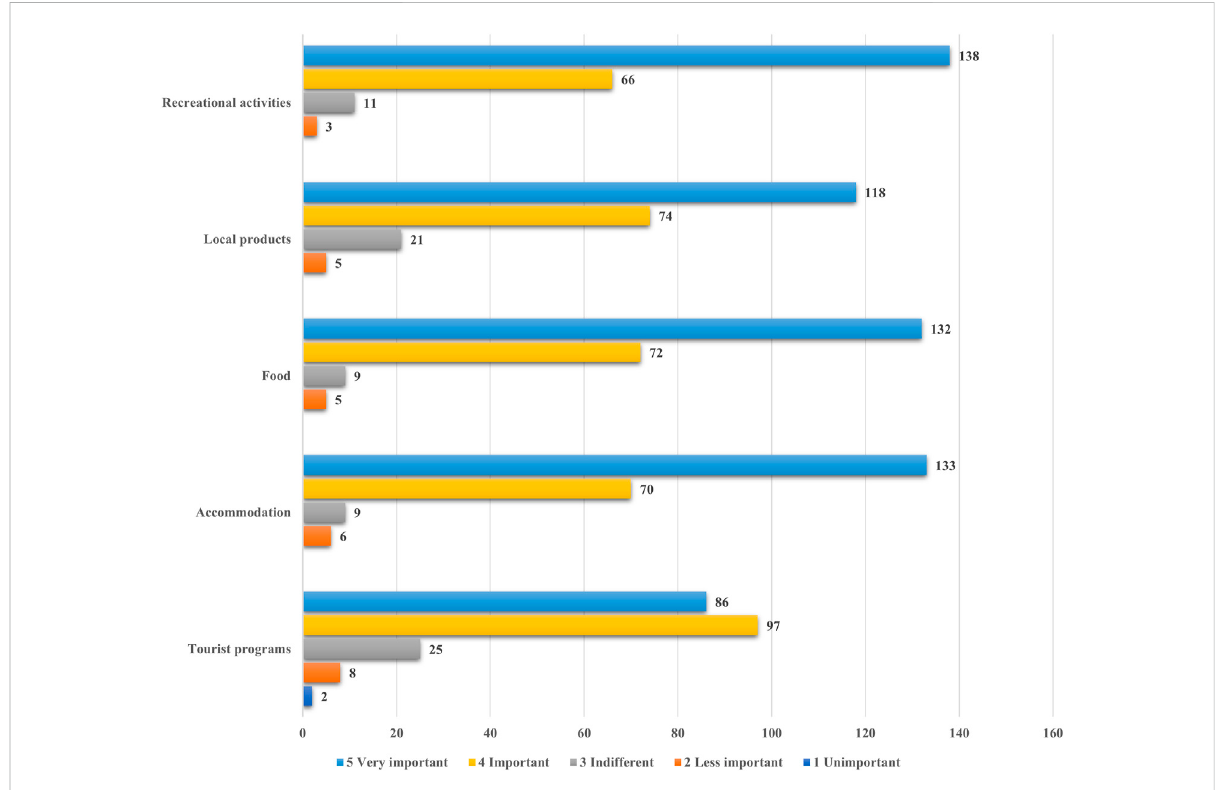
FIGURE 4 Most important aspects that contribute to the choice of an ecotourism destination.